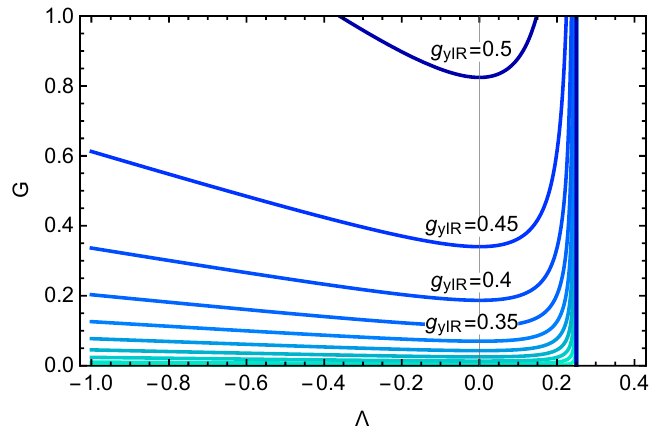
Figure 6 . Lines of constant IR values of g Y in a zoom in the region around (cid:3) (cid:25) 0 for vanishing anomalous dimension of the metric (cid:17) h = 0. Within our truncation, lines of di(cid:11)erent IR values of g Y are pulled closer together as (cid:3) approaches the critical value at which the interacting (cid:12)xed point merges with the free one. This moves the phenomenologically preferred values of G to signi(cid:12)cantly smaller